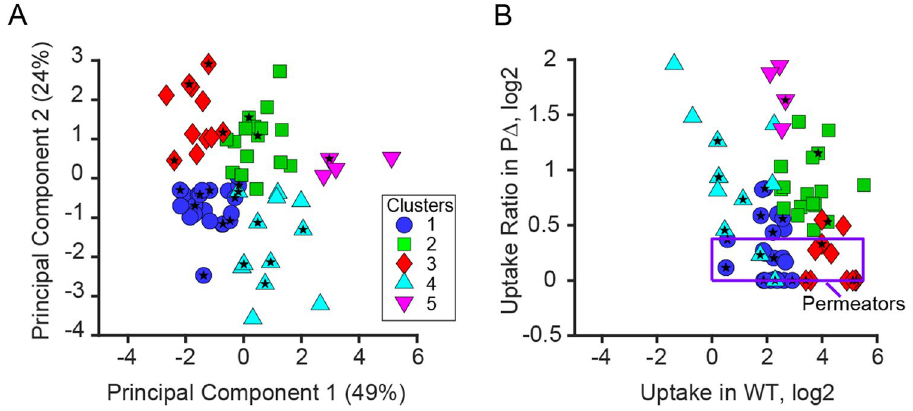
Figure 4. Distribution of uptake data in the activity space in PC ( A ) and native ( B ) coordinates. Crosses mark centers of clusters determined using k -means clustering. Violet rectangle encompasses compounds defined as good permeators. Stars mark